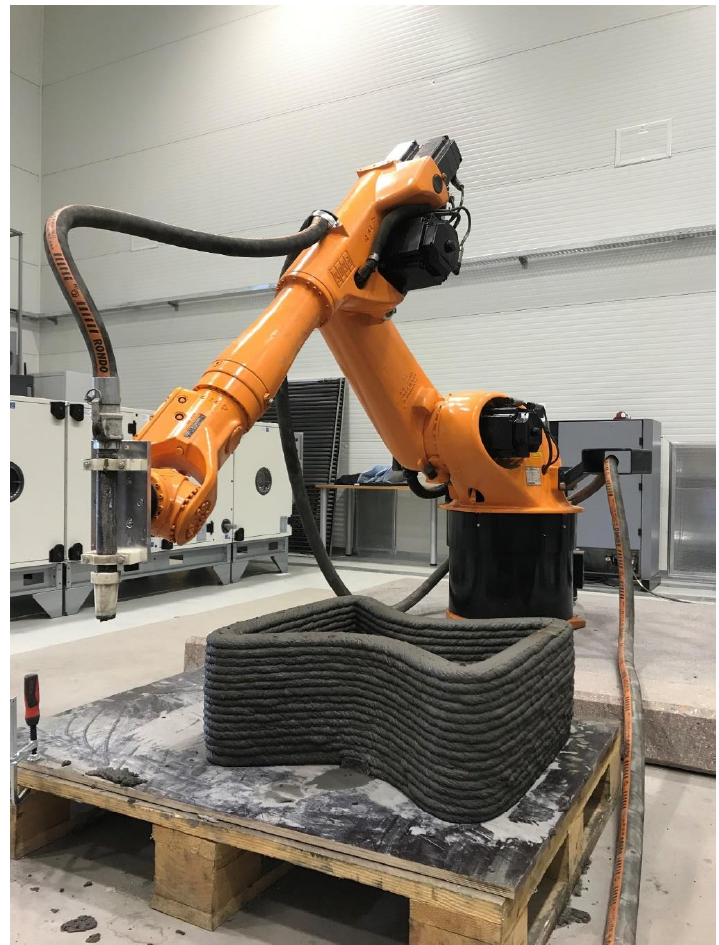
Figure 1. 3D printing of a geometric element.